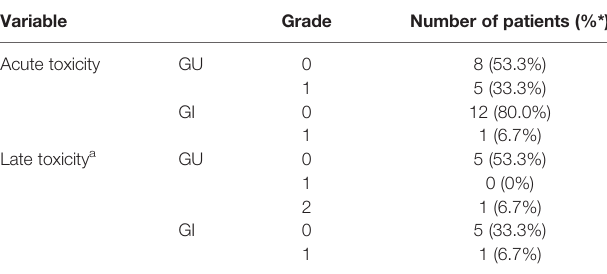
TABLE 3 | Induced acute and late